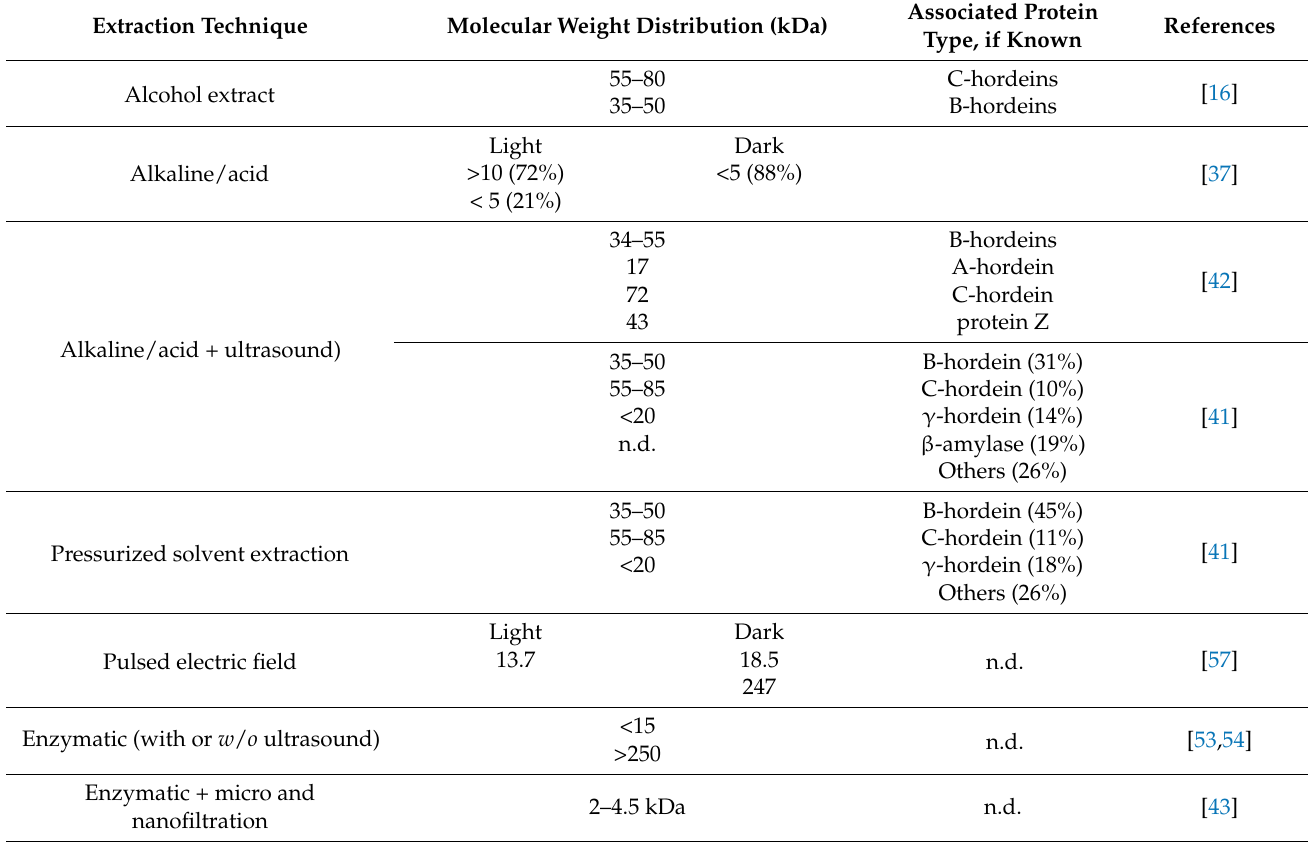
Table 4. Protein composition of BSG protein extracts obtained through different extraction techniques. The molecular weight distribution and the associated protein types are listed in the order of their decreasing contribution to the total protein